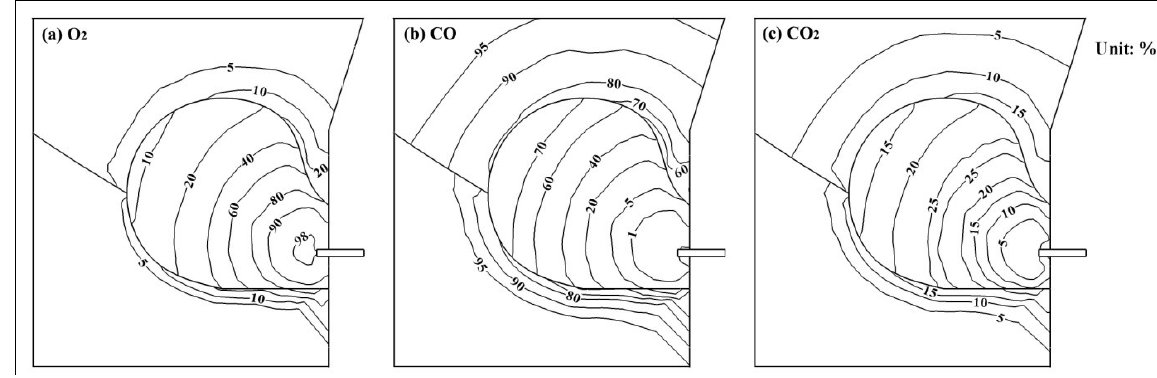
Figure 4: Volume fraction distributions of gas species around raceway